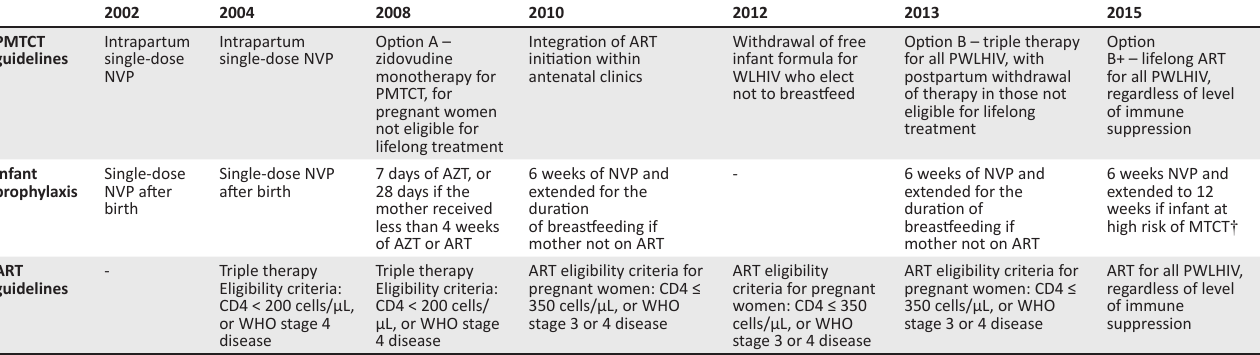
TABLE 1: Evolution of the South African prevention of mother-to-child transmission and antiretroviral therapy guidelines, 2002–2015. 18,19,20,21,23,24